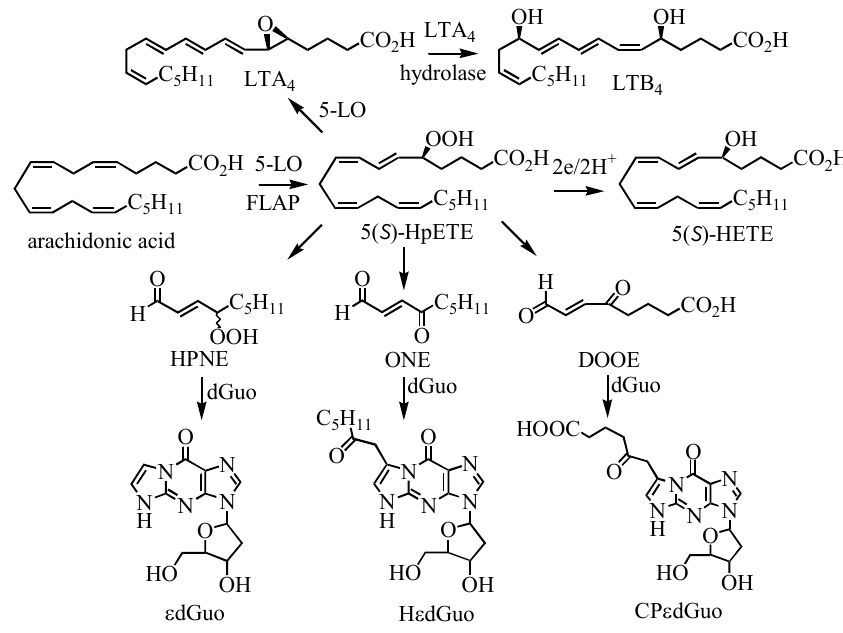
Figure 5. 5-LOX-mediated formation of arachidonic acid metabolites and dGuo-adducts. HPNE, 4-hydroperoxy-2(E)-nonenal; DOOE, dioxo-6-octenoic acid. Reprinted with permission from Ref.